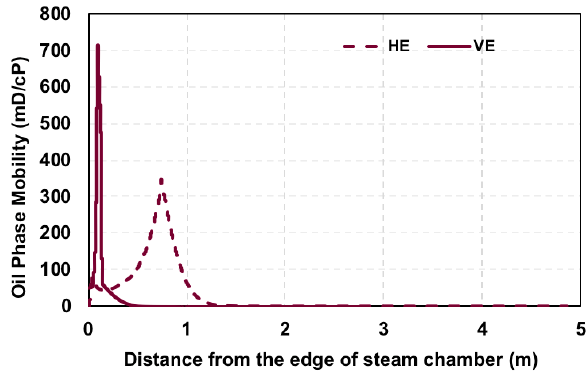
Figure 17. Oil phase mobility profile versus distance for VE and HE models.